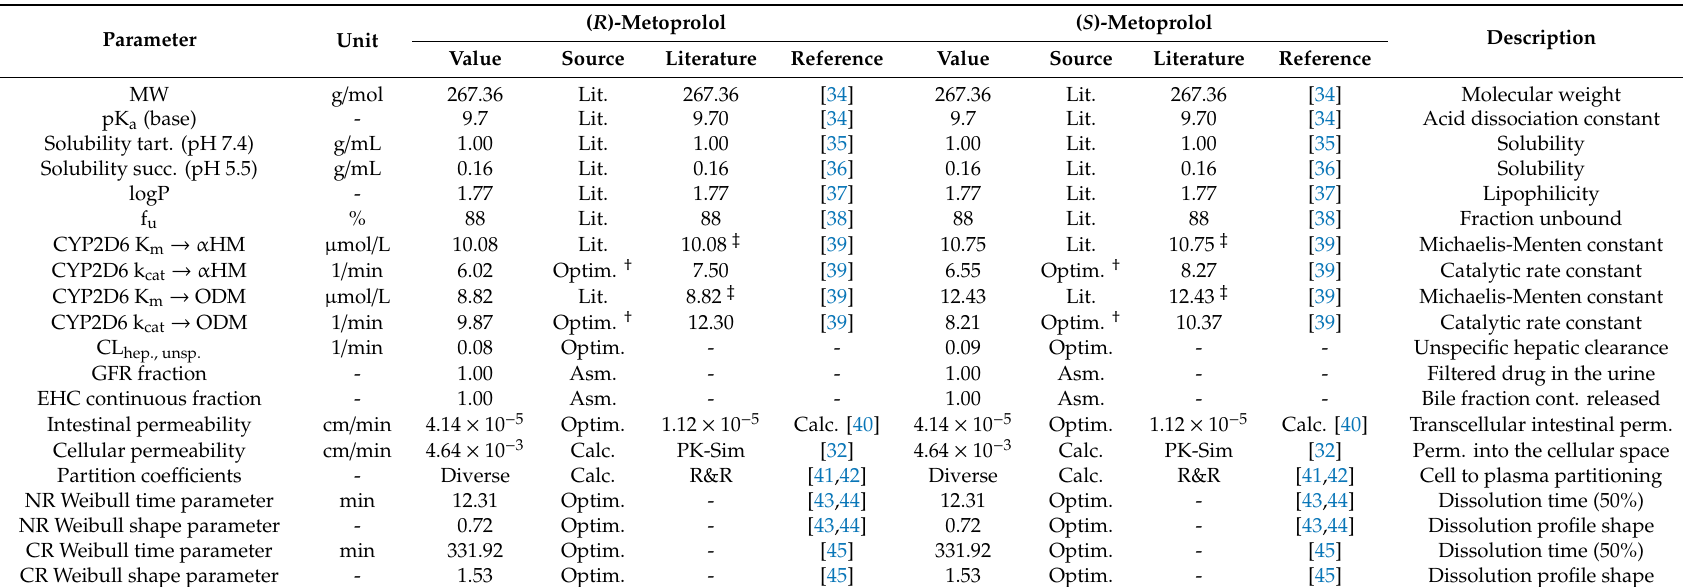
Table 2. ( R )- and ( S )-metoprolol drug-dependent model parameters.